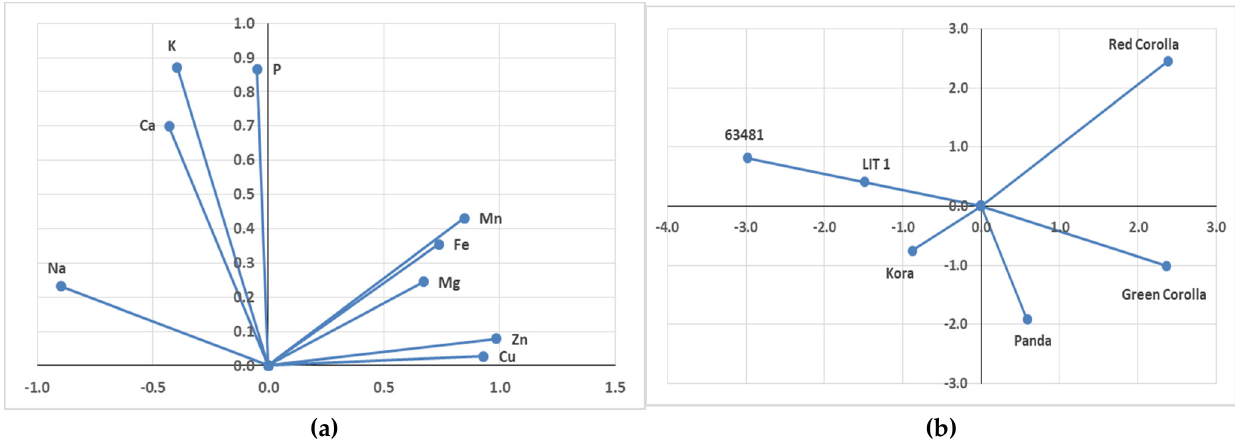
Figure 2. Principal component analysis (PCA) of seed mineral content of F. esculentum and F. tataricum genotypes ( a ) and individual graph of the tested genotypes ( b ).